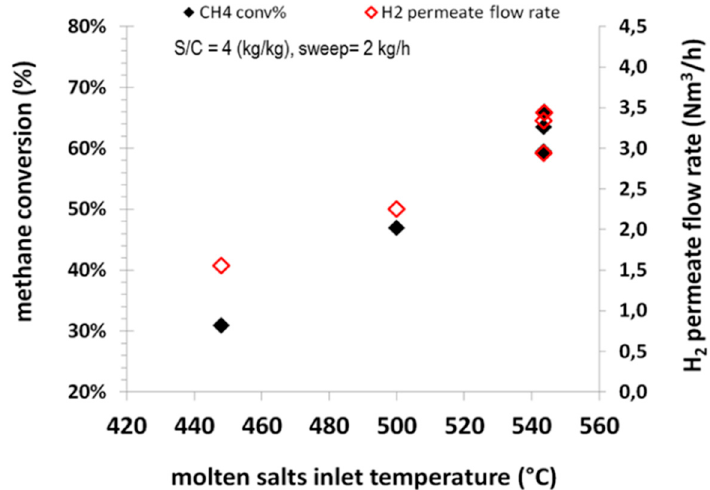
Figure 6. Effects of molten salts temperature on the methane conversion and the permeate H 2 flow rate.